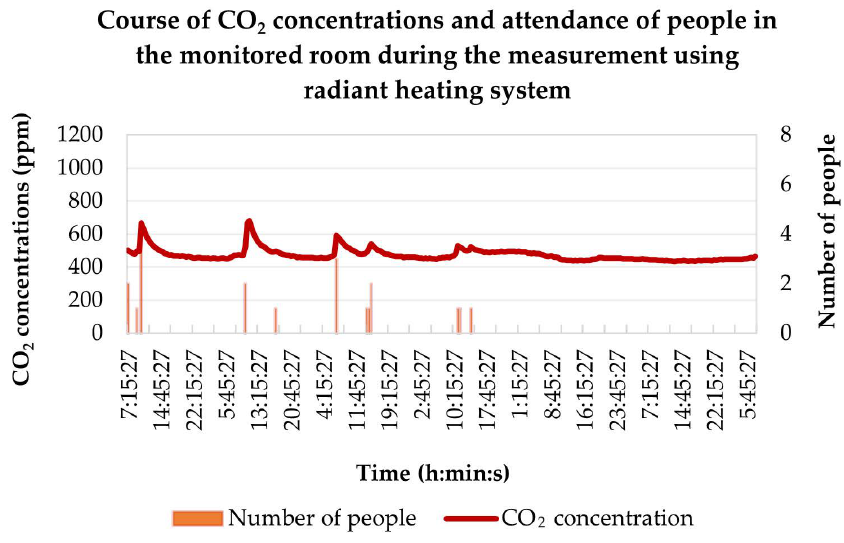
Figure 10. Course of CO 2 concentrations and attendance of people in the monitored room during the measurement using RHS.